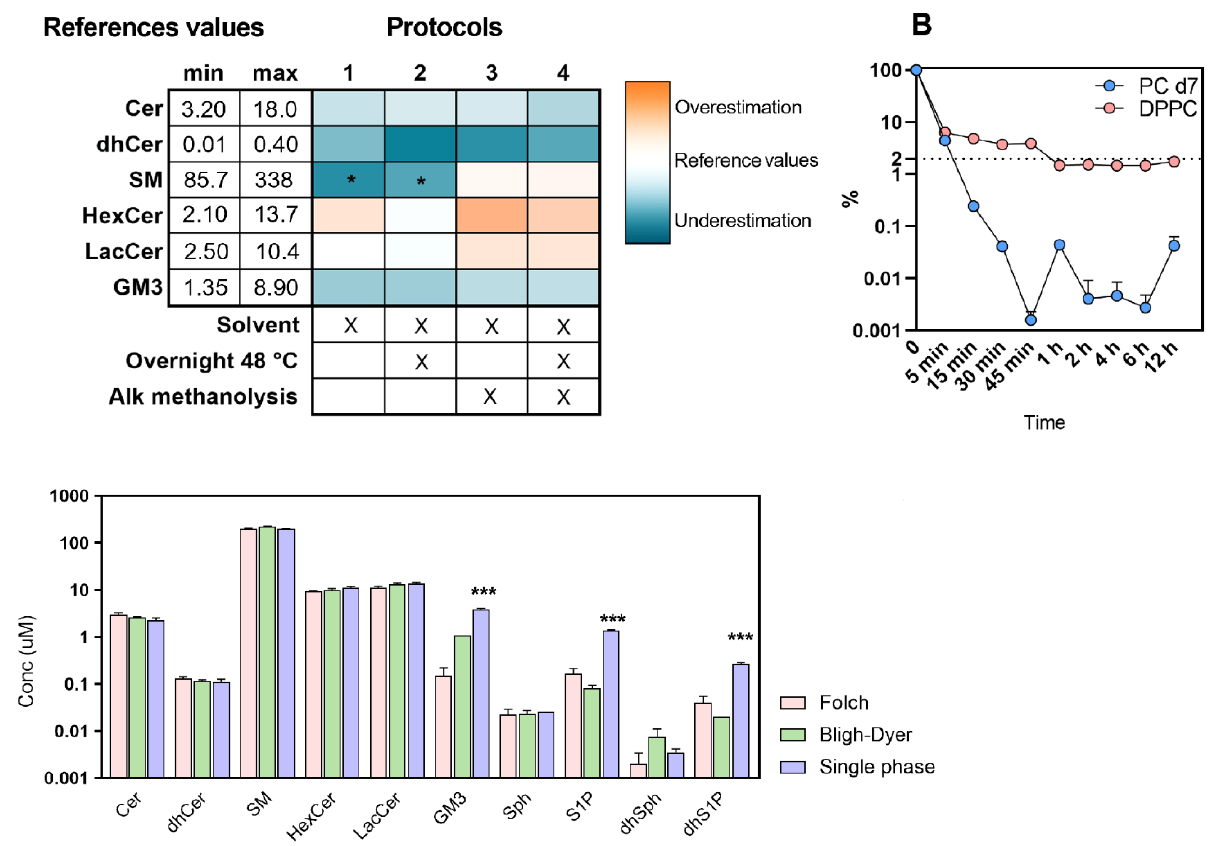
Figure 1. ( A ) Quantification of sphingolipids in a plasma pool from healthy volunteers ( n = 20) as a function of different extraction protocols and comparison to the reference values found in the scientific literature. On the left of the heatmap, the range of concentration ( µ M) of sphingolipids in plasma EDTA from healthy volunteers found in the scientific literature [19 – 27]. For visualization, data were scaled to reference values and reported as a fold-change logarithm. Those significantly modulated were evaluated by performing repeated measures one-way ANOVA and the Dunnett post hoc test. The different steps in each protocol are schematized under the heatmap and their occurrence is marked with an “ X ” . ( B ) Estimation of plasma phospholipids content after alkaline hydrolysis (KOH 73 mM) over time (0, 1, 2, 4, 6, 12 h) at 38 °C. Data were visualized as a percentage of DPPC and PC d7 with respect to untreated samples. Each point represents the mean of n = 2 technical replicates. ( C ) Comparison of the traditional liquid – liquid extraction for total lipid content (Folch n = 3 and Bligh – Dyer n = 3) and the single-phase extraction ( n = 3) for the recovery of sphingolipids in a plasma pool from healthy volunteers ( n = 20). Statistical differences were measured by one-way ANOVA and the Dunnett post hoc test against monophasic extraction. p values are schematized as follows: * < 0.05; *** < 0.001.